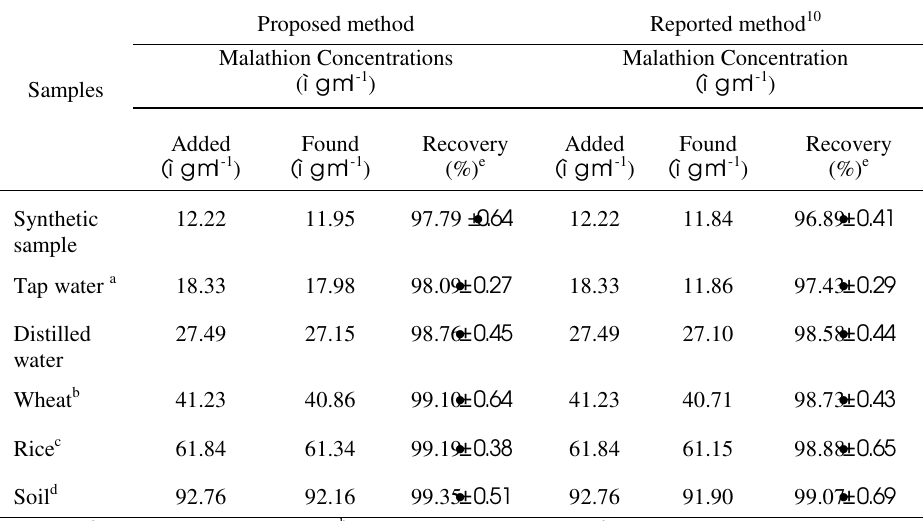
Table 4 Determination of malathion in various environmental samples Proposed